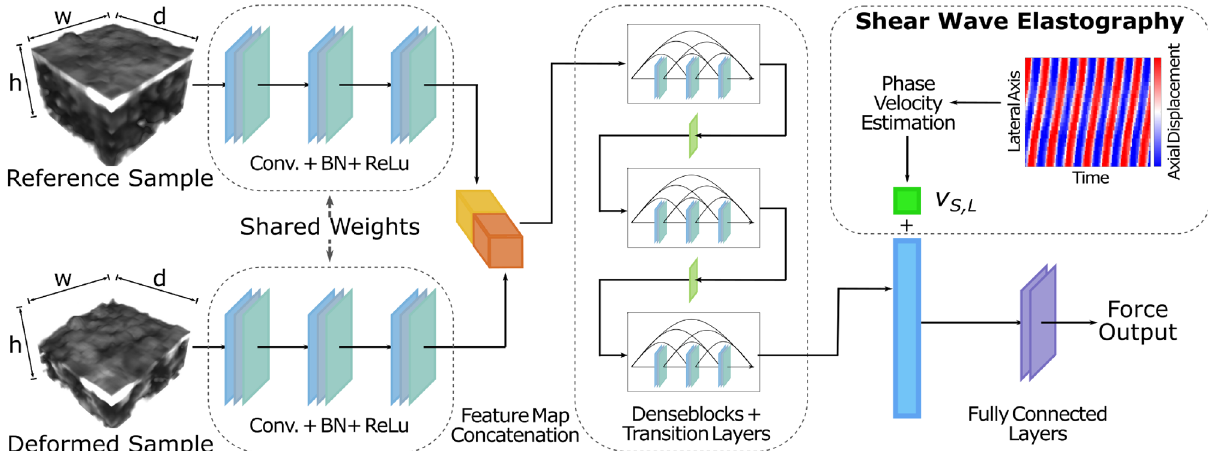
Figure 4. Data Processing: Siamese DenseNet architecture with fusion of SWEI phase velocity. The input and a reference sample are initially processed separately and the obtained feature maps are aggregated. SWEI fusion can optionally be conducted by appending the phase velocity v S , L after the GAP. Convolutional layers employ 3D convolutions for V t (depicted above) and 2D convolutions for D t . Input sizes h × w × t are 32 × 32 × 32 and 1 × 32 × 32 for V t and D t ,